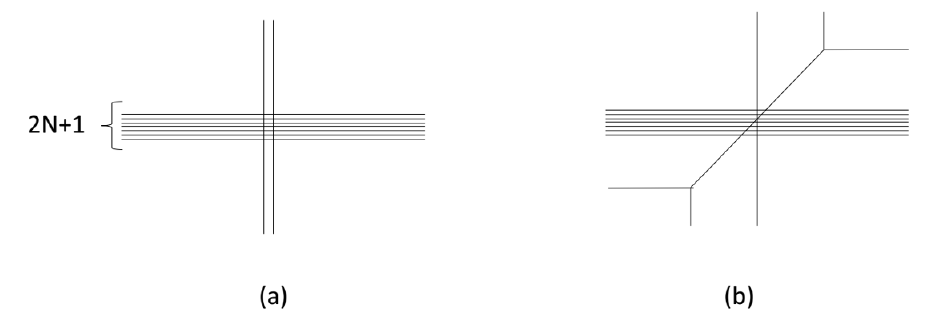
Figure 4 . (a) The brane web for a 5d SCFT with global symmetry SU(4 N + 2) (cid:2) SU(2) 2 . (b) The same web after moving some of the 7-branes. This corresponds to a mass deformation of the 5d SCFT. As can be seen from the web, this mass deformation sends this 5d SCFT to the 5d SCFT in (cid:12)gure